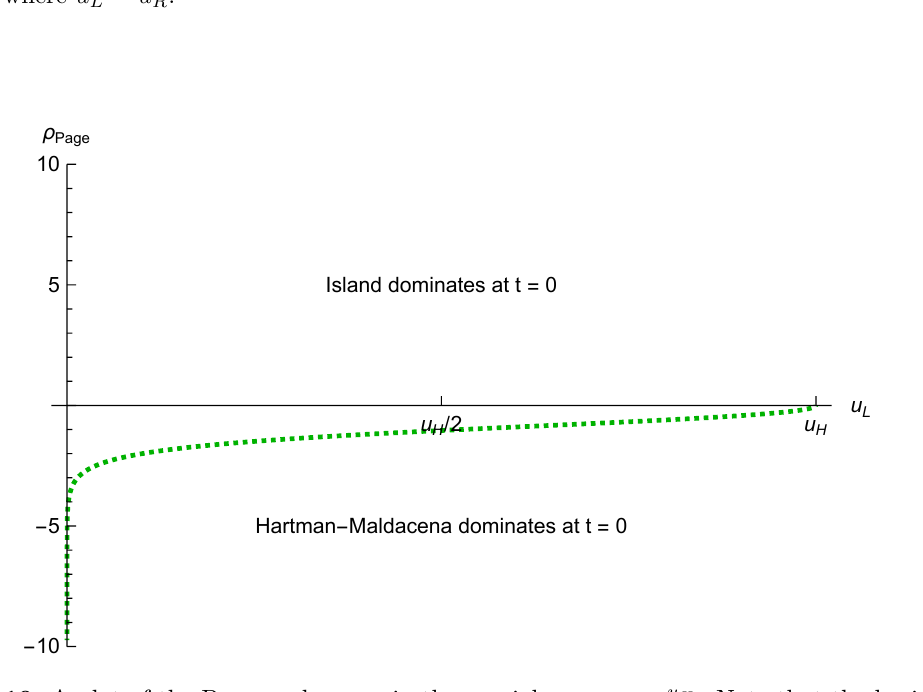
Figure 9 . A plot of the Page angle ρ Page in the special case u = u L = u R . The point at which the Page angle gives the tensionless brane ρ = 0 is marked on the horizontal axis, at u = (2 The regions in which the island and Hartman-Maldacena surfaces initially dominate the entropy calculation are marked. This plot is equivalent to plotting the density along a diagonal slice of figure 8 where u L = u R .